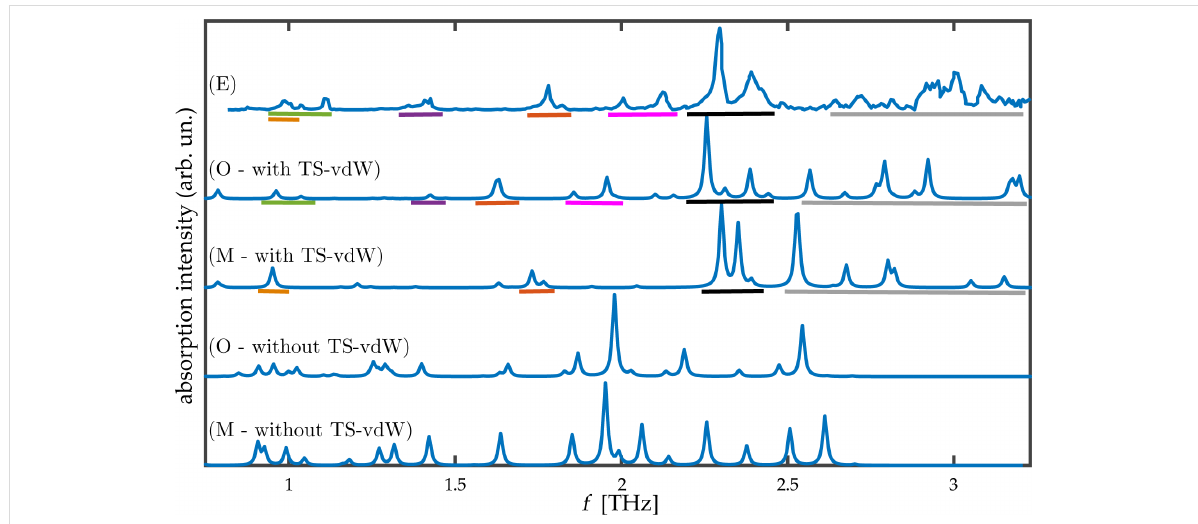
Figure 2: Absorption intensity (in arbitrary units) as a function of the frequency for the two TNT polymorphs studied in this work. (E) Experimental spectrum for the mixed-polymorph TNT crystal, taken from [16], as captured by a data analysis program. All other spectra are computed for: (O) the orthorhombic structure and (M) the monoclinic structure, calculated with and without TS-vdW interactions. Colored horizontal lines appearing below various experimental and computed peaks denote peak assignment.